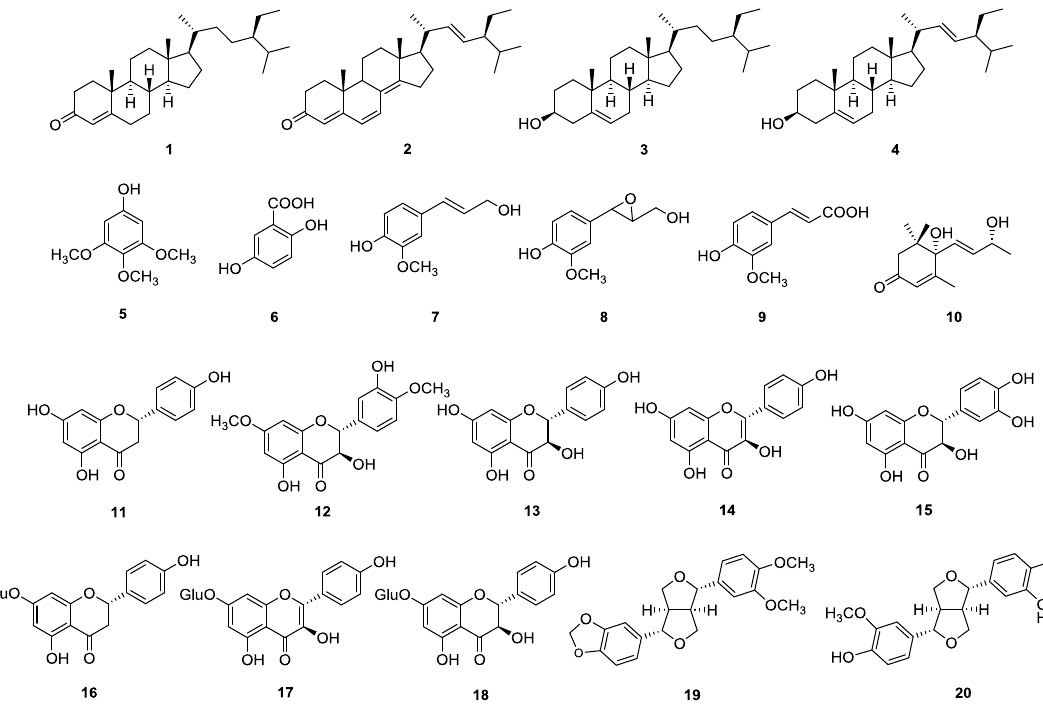
Figure 1. Chemical contents of the dried bark from Cochlospermum vitifolium .